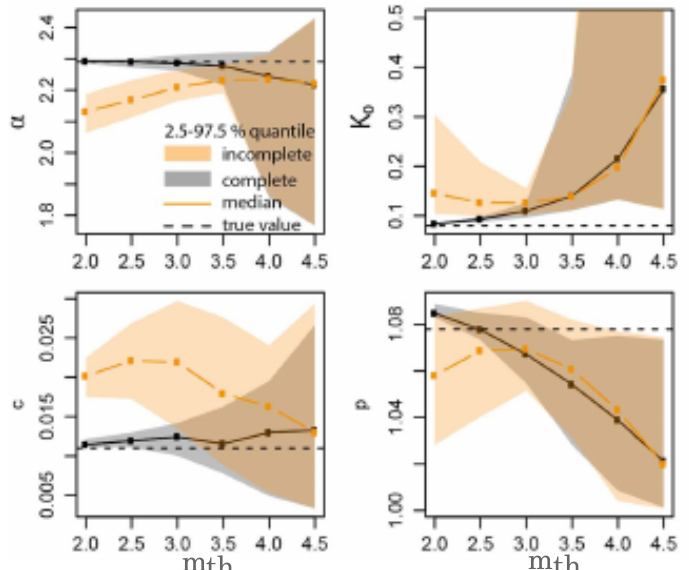
Figure 5. The ETAS parameters are plotted against m th for synthetic catalogs simulated with parameters from Southern California (gray) and compared with the parameter for the incomplete synthetic catalog (orange). The “true” parameter values are plotted with black dashed lines the grey shadowed region represents the 95% quantiles of 30 synthetic ETAS catalogs. The orange shadowed region represents the 95% quantiles of 30 synthetic ETAS incomplete catalogs. From